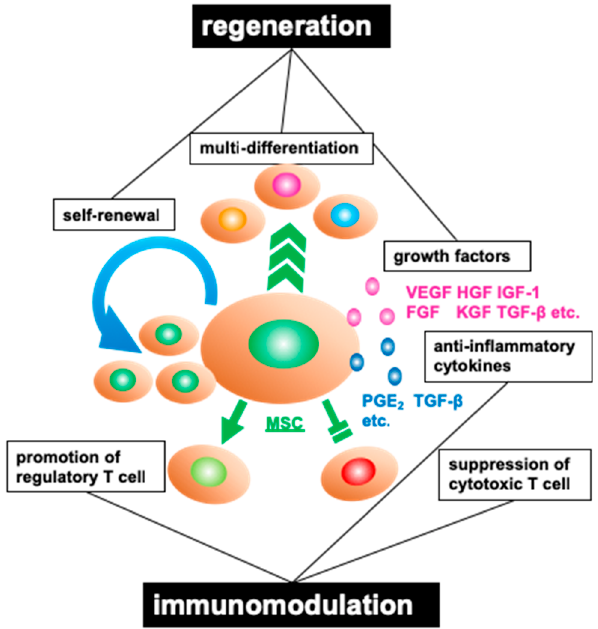
Figure 1. Major properties of mesenchymal stromal cells (MSCs). MSCs are capable of self-renewal, regeneration multi-differentiation, and are endowed with immunomodulatory potential. These cells express various growth factors (e.g., VEGF, vascular endothelial growth factor; HGF, hepatocyte growth factor; IGF-1, insulin-like growth factor-1; FGF, fibroblast growth factor; KGF, keratinocyte growth factor; TGF- β , transforming growth factor- β ) and anti-inflammatory cytokines (e.g., PGE2, prostaglandin E2). MSCs also suppress the activities of cytotoxic T cells and promote the production of regulatory T cells.